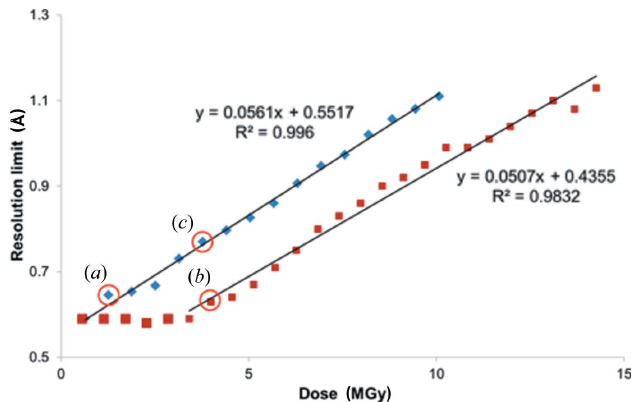
Figure 6 The variation in suggested resolution limit (calculated from CC 1/2 ) as a function of dose for experiment 1 (diamonds) and experiment 4 (squares). The two experiments were performed at the same beamline settings and the experimental resolution limit was 0.59 A˚ . Circles ( a ), ( b ) and ( c ) indicate datasets with similar resolution [( a ) and ( b )] or similar dose [( b ) and ( c )] (see discussion below).